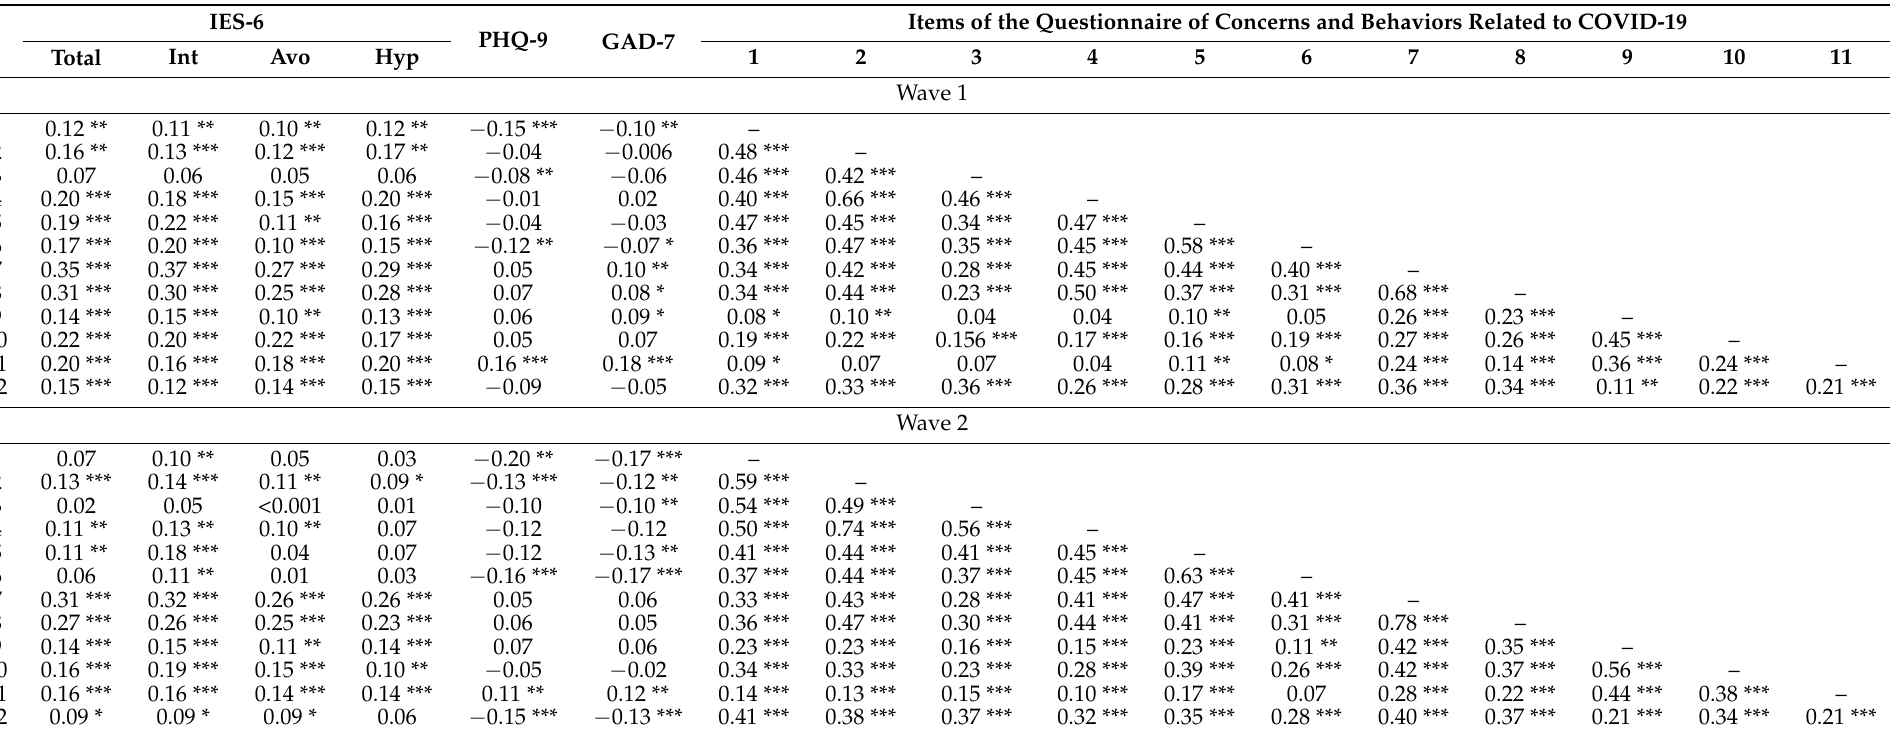
Table 3. Correlation analyses event-related distress, depression, and anxiety, and concerns and behaviors related to COVID-19. IES-6 PHQ-9